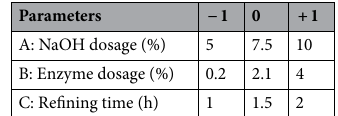
Table 2. The 2 3 factorial experimental